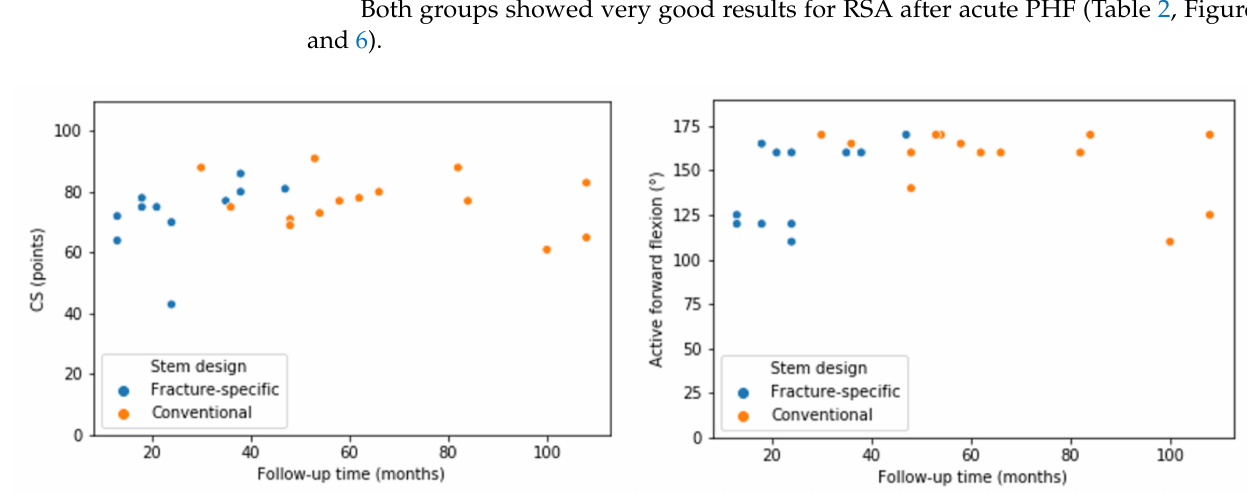
Figure 5. Scatter plots for CS and active forward flexion for both stems with regards to follow-up time. Function for CS and forward flexion are lower in those patients with early follow-up. This statistical significance might be biased due to further improvement in function in the second year after